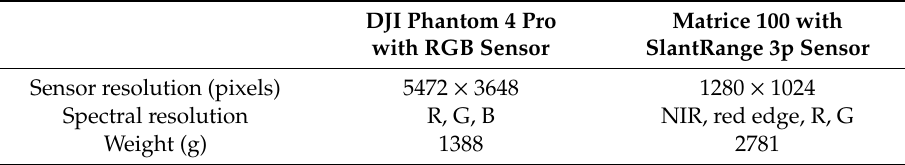
Table 1. Specifications for the UAS and the sensors used to collect the